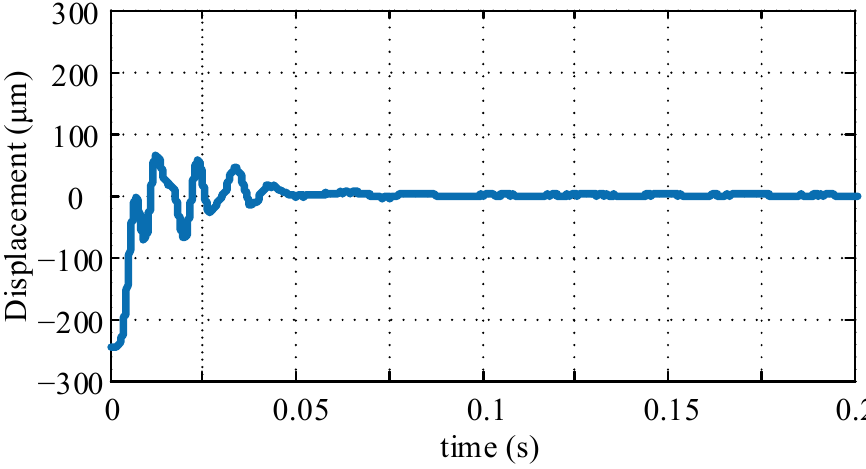
Figure 16. Levitation response curve with the μ -controller.